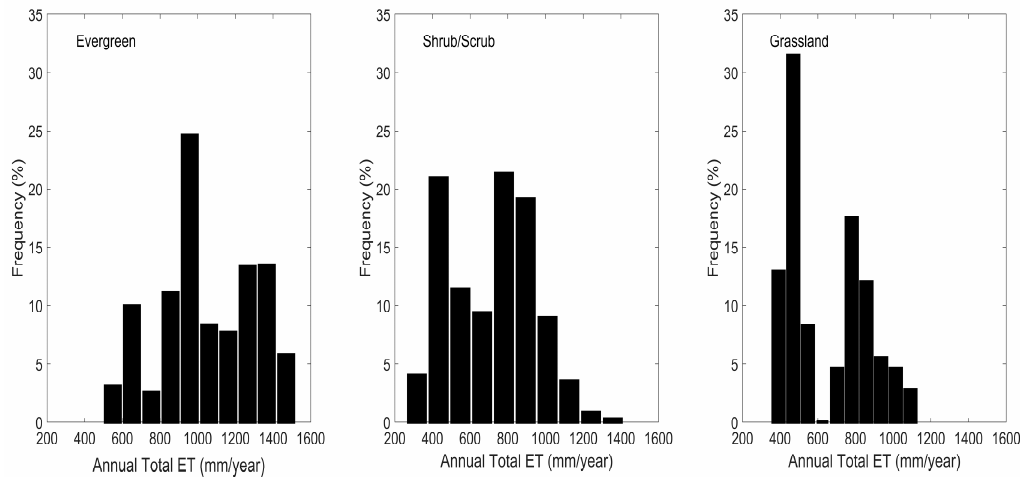
Figure 3. Histogram of the annual total ET for selected land cover classes evergreen forest, shrub/scrubland, and grassland within the study domain.